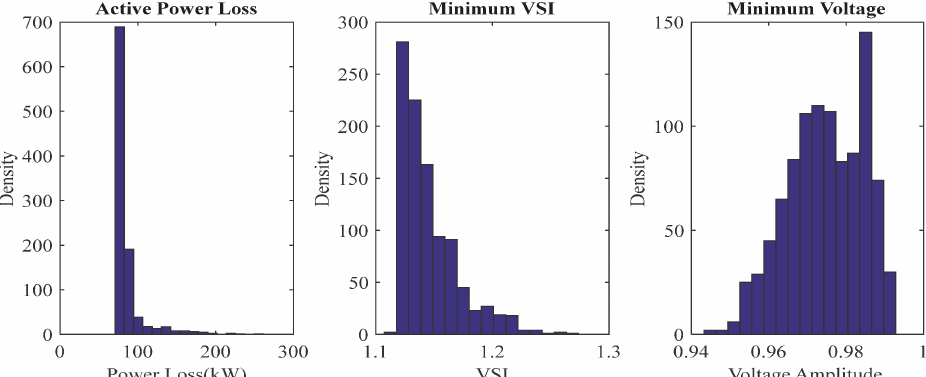
Figure 17. Stochastic results based on PDF for allocating two PVs in the 33-bus system with uncer- tainties using IHLOA.